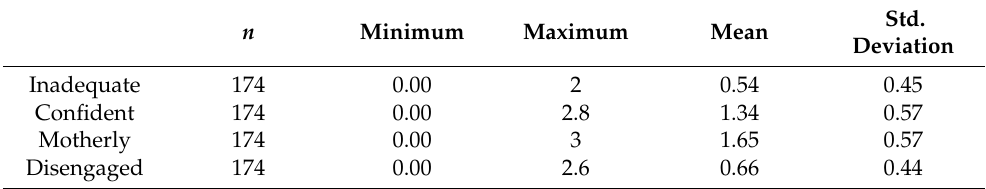
Table 4. Range and mean of CT subscales from all sessions.